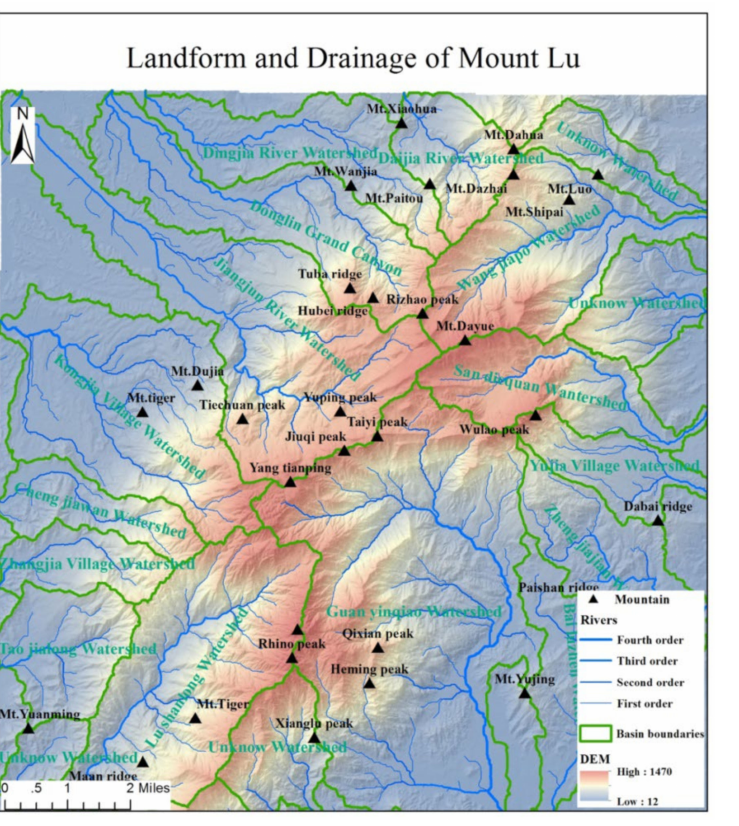
Figure 1. Landform and drainage of Mount Lu.